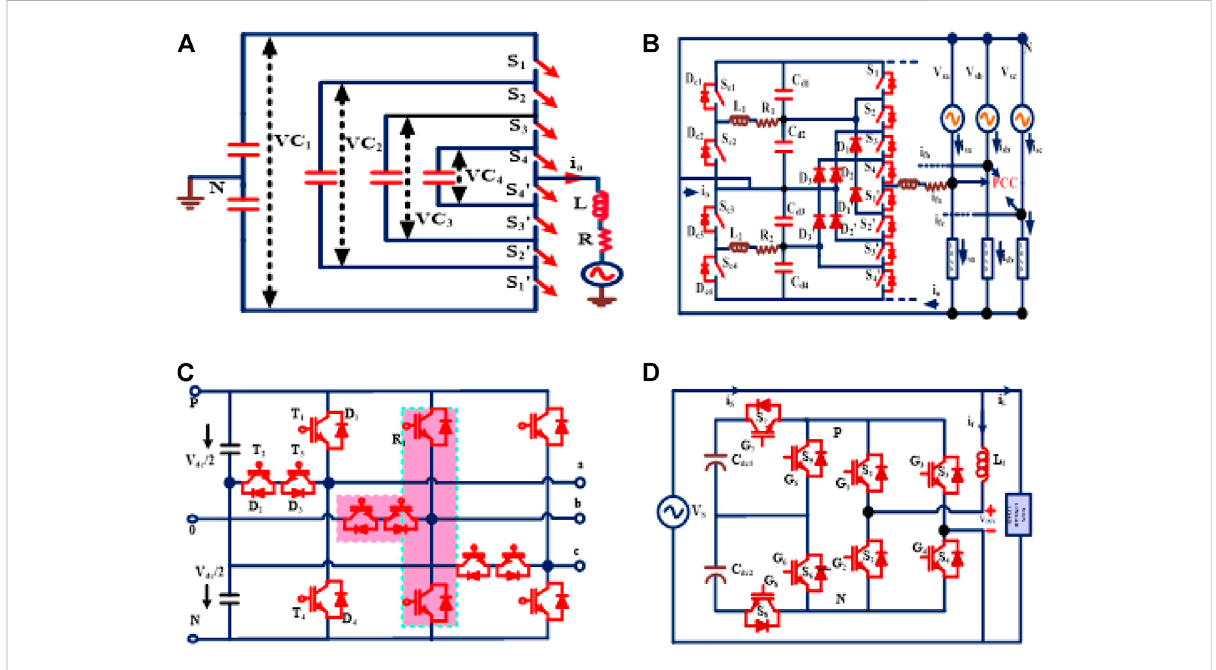
FIGURE 1 Existing DSTATCOM with differentmultilevel inverter topologies (A) presented in (Shukla,2007a), (B) presented in(Shukla, 2008), (C) presented (Palanisamy and Vijayakumar, 2022), and (D) simpli fi ed four-level inverter